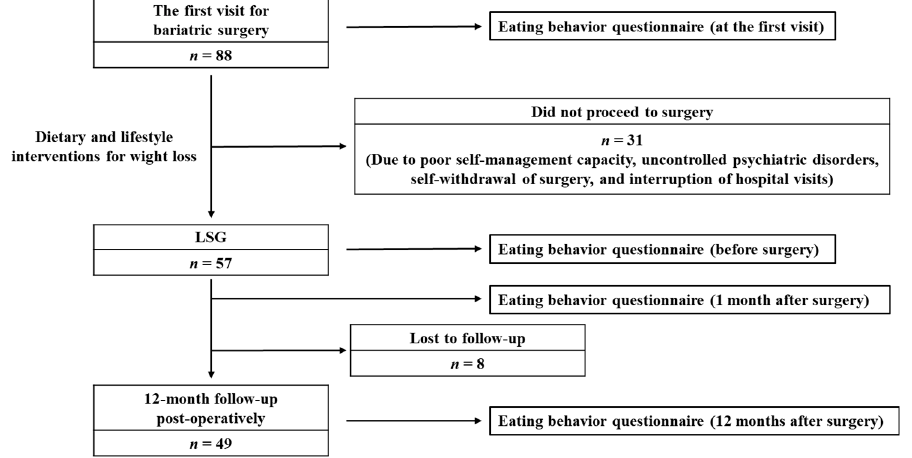
Figure 1. Enrollment and follow-up of the study subjects. Eighty-eight patients visited our hospital as possible candidates for metabolic and bariatric surgery. Of these, 57 patients who underwent laparoscopic sleeve gastrectomy (LSG) enrolled in the present study. Eight were lost to follow-up until 12 months after surgery and the remaining 49 patients were subjected to